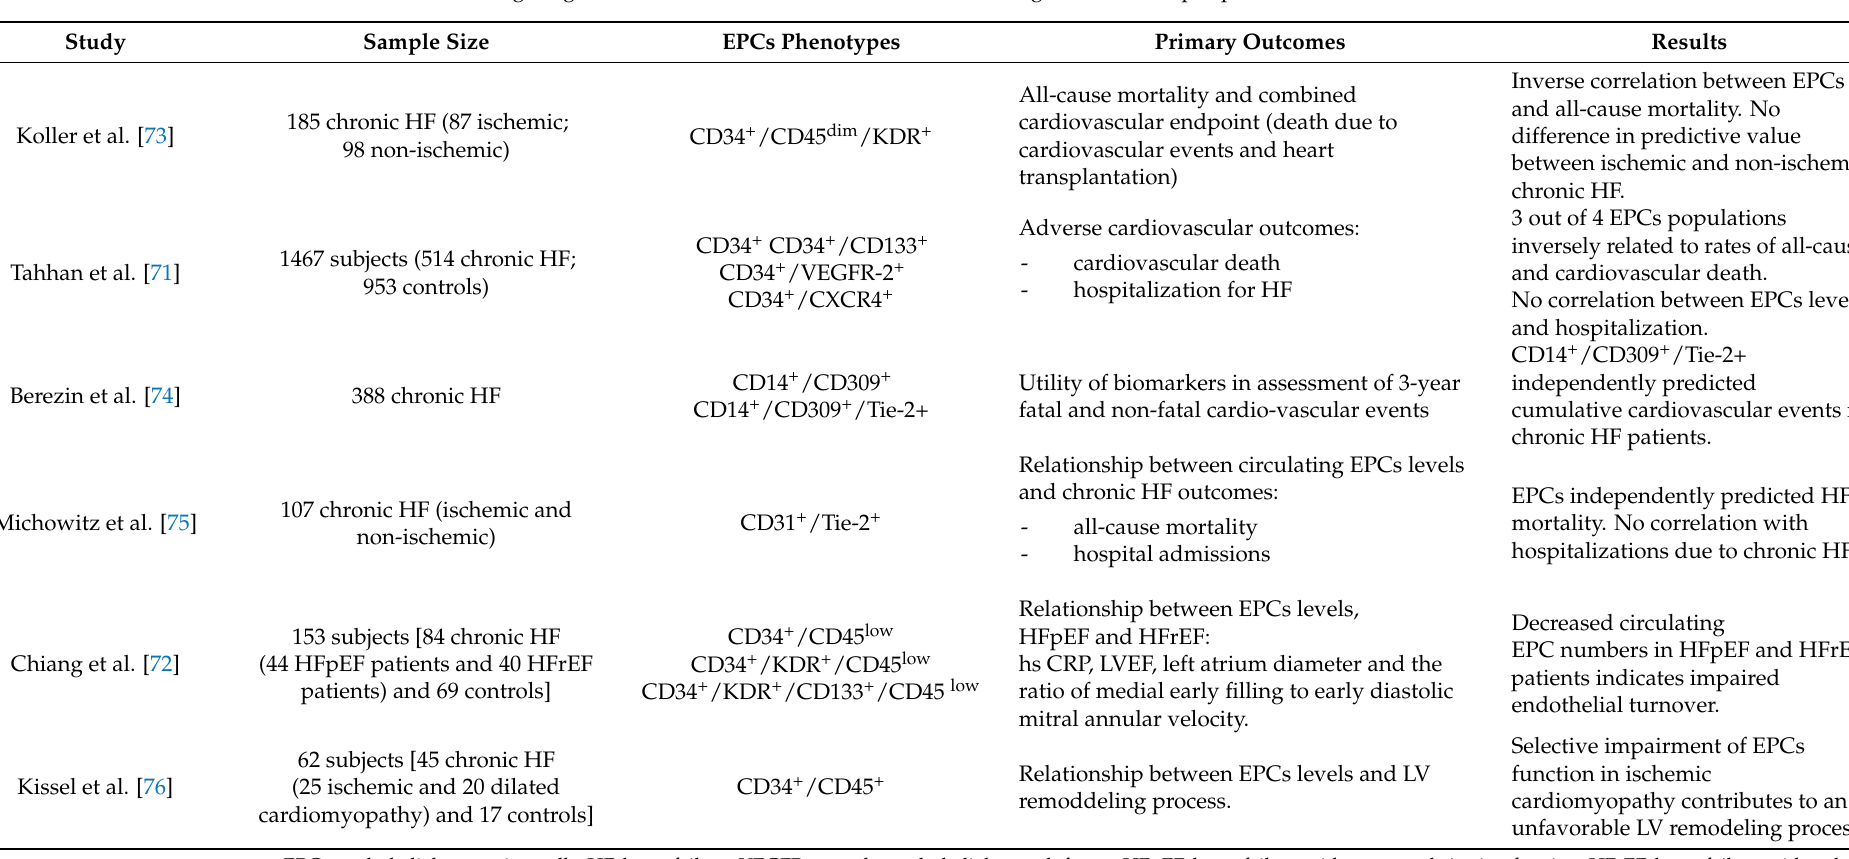
Table 1. Studies investigating the relation between levels of Endothelial Progenitor cells in peripheral circulation and outcomes in chronic heart